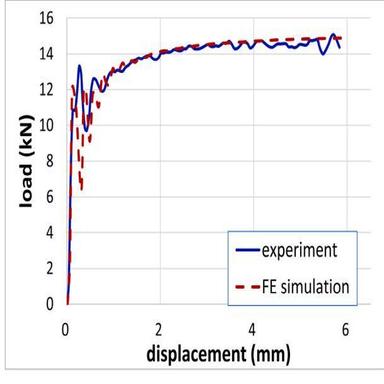
Comparison of load-displacement curves for DP780.